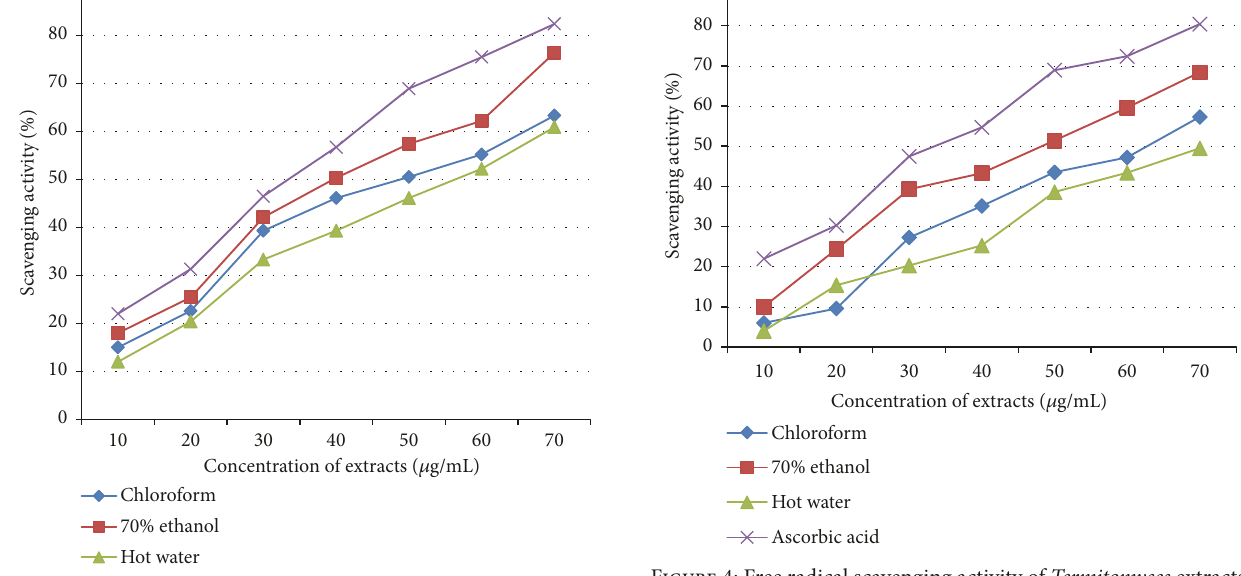
incubated for 30 min to 3 h at 37 ∘ C and 30 ∘ C for bacteria